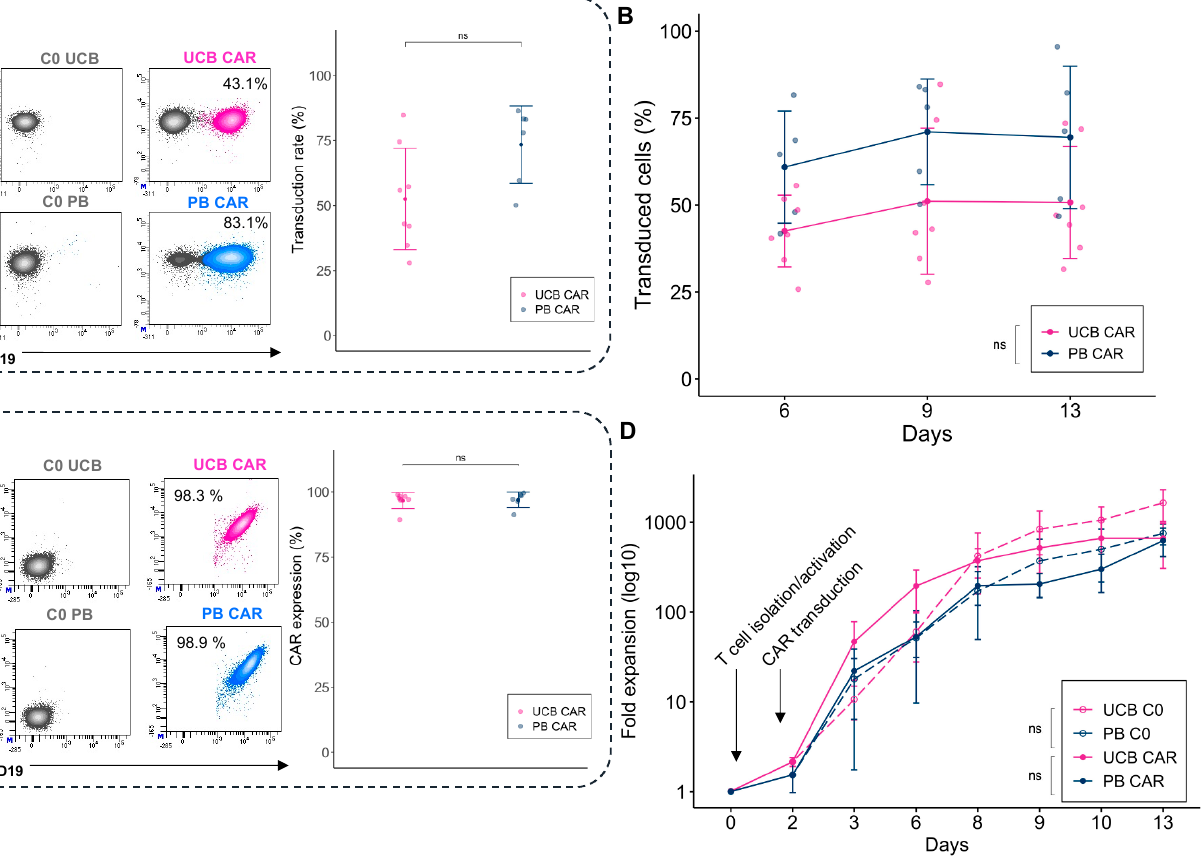
Figure 1. Generation of CAR-T derived from fresh UCB and PB. ( A ) Representative example of flow cytometry plots to determine the transduction efficiency (left) and mean CAR CD123 transduction rate (day 9) between UCB CAR-T (pink) and PB CAR-T (blue). ( B ) Percentage of transduced cells over time between UCB CAR-T (pink) and PB CAR-T (blue). ( C ) CAR expression using CD19: examples of flow cytometry plots (left) and percentage of CAR expression among T cells at day 9 (right). ( D ) Fold expansion of the untransduced T cells from UCB and PB (UCB C0 and PB C0), and CAR-T from UCB and PB (UCB CAR-T and PB CAR-T), after T cell isolation, activation, and transduction ( n = 8 for UCB, n = 7 for PB). UCB: Umbilical Cord Blood, PB: Peripheral Blood. ns: non- significant.